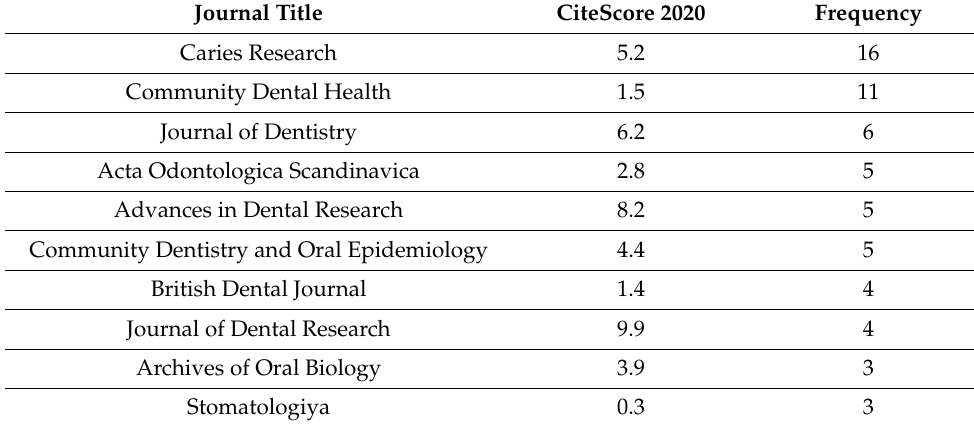
Table 2. Top 10 journals where original research articles on milk fluoridation were published.